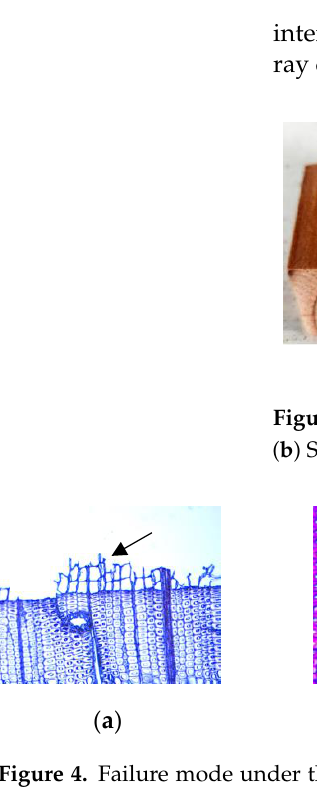
Figure 3. Failure patterns extending to different growth rings. ( a ) Sample 19 with wide rings. ( b )